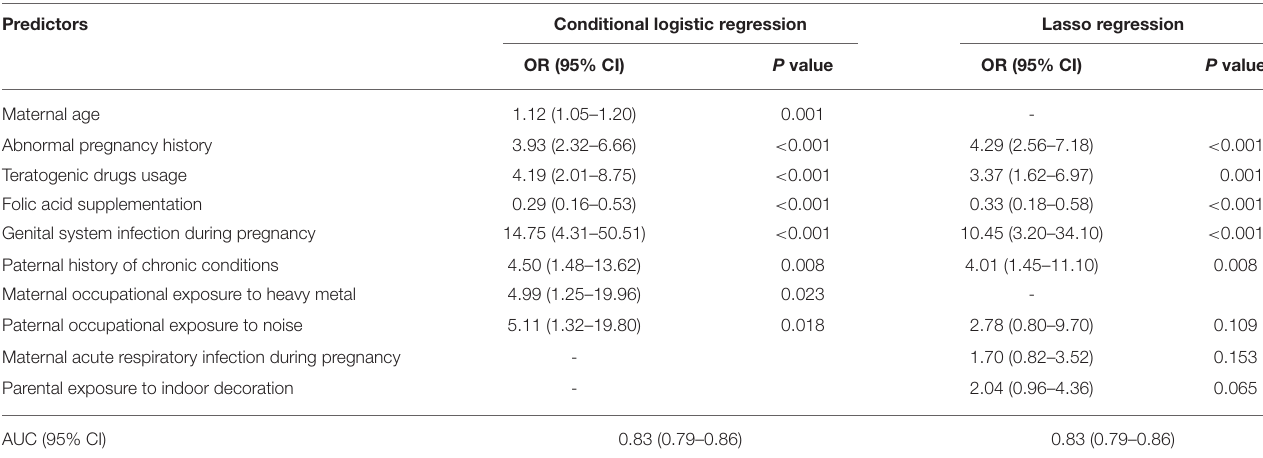
TABLE 3 | The associations (ORs and 95% CIs) between selected predictors and microtia according to multivariate conditional logistic regression and lasso regression, respectively. Predictors Conditional logistic